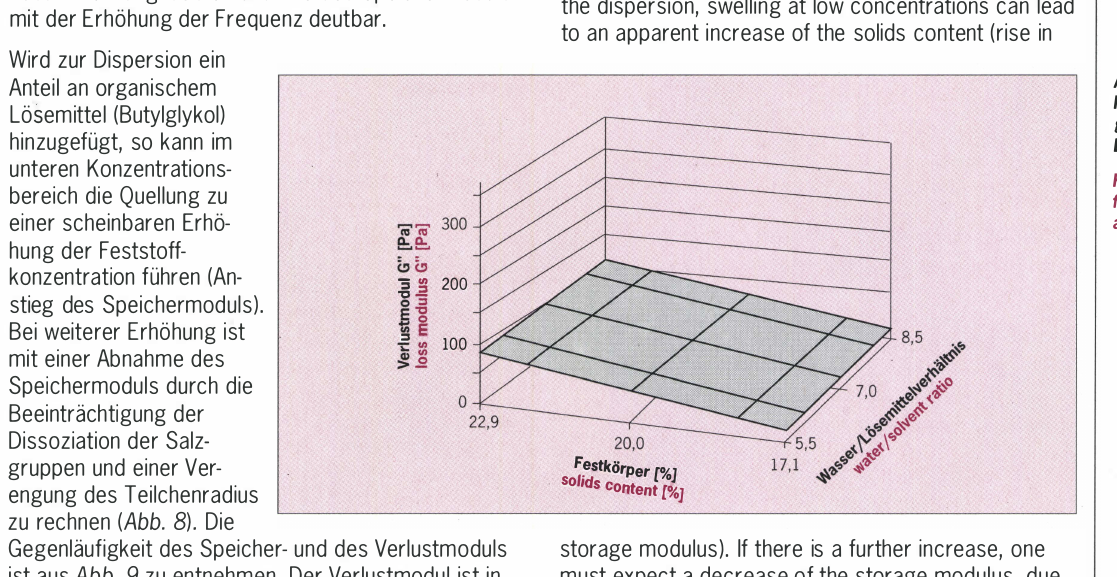
Fig. 9: Loss modulus as a function of the solids content and the water: solvent